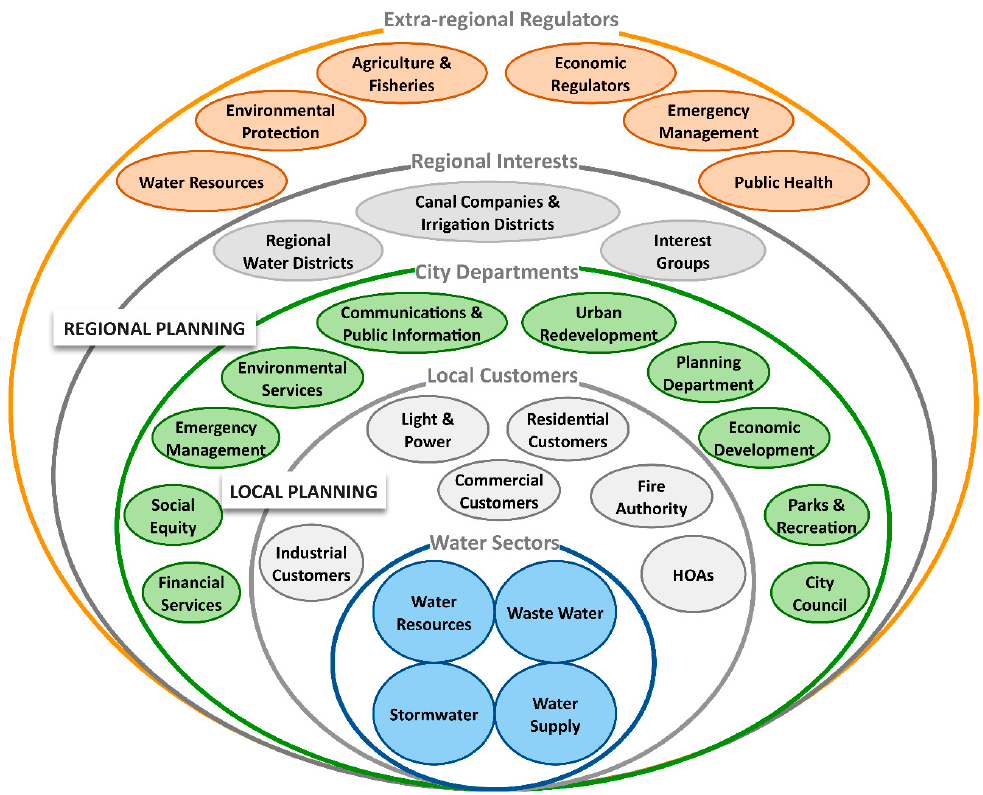
Figure 5. Integrated urban water management (IUWM) Participants.